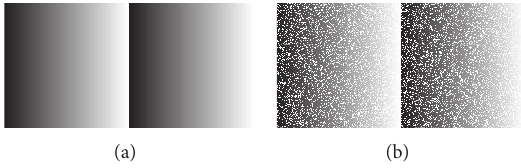
Figure 3: Example of a regression training image with a height of 128 and 20% added noise. (a) Nonnoisy image taken as model. (b) Noisy image with 20% white